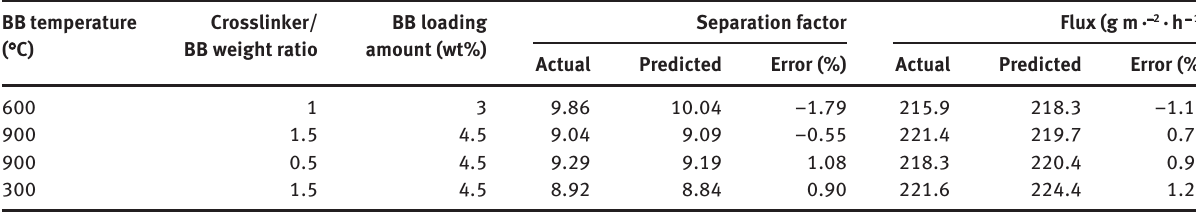
Table 5: Conformation